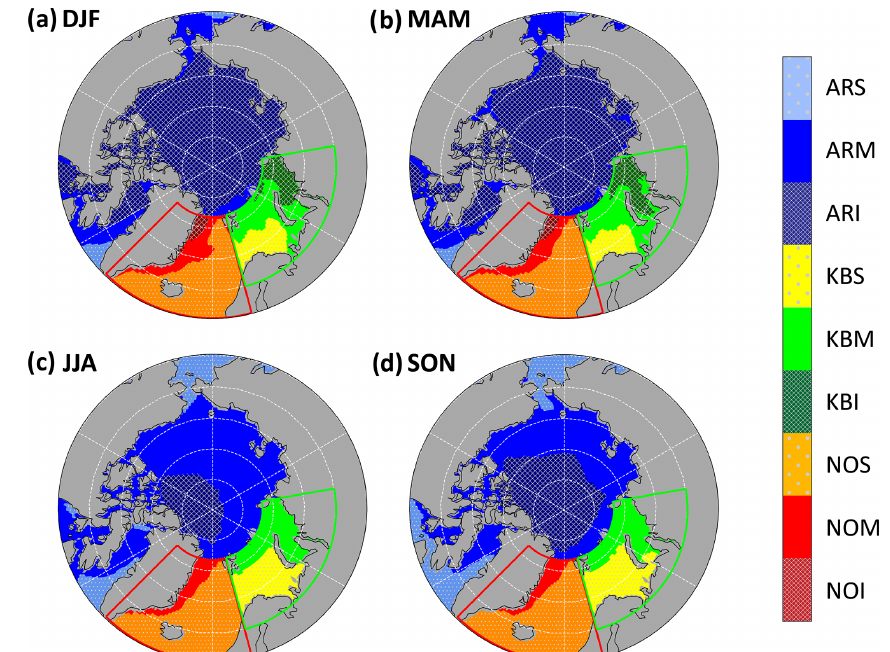
Figure 1. Sub-regions defined based on SIC clim in (a) DJF, (b) MAM, (c) JJA and (d) SON. The labels refer to Nordic Seas ice (NOI), Nordic Seas mixed (NOM), Nordic Seas sea (NOS), Kara and Barents seas ice (KBI), Kara and Barents seas mixed (KBM), Kara and Barents seas sea (KBS), Arctic residual ice (ARI), Arctic residual mixed (ARM), and Arctic residual sea (ARS). Green and red boxes denote the areas of the Kara and Barents seas and Nordic Seas regions,